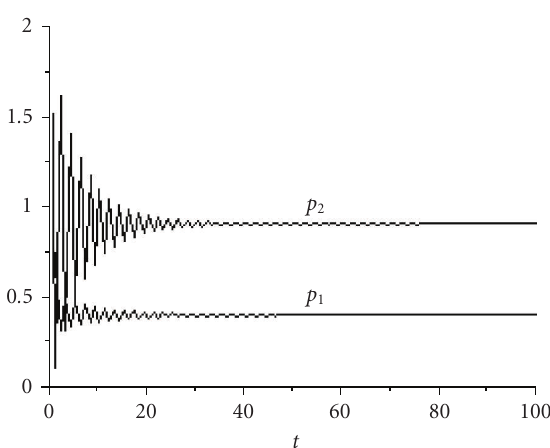
Figure 4.11 . Time series of p 1 and p 2 with k = 0 .